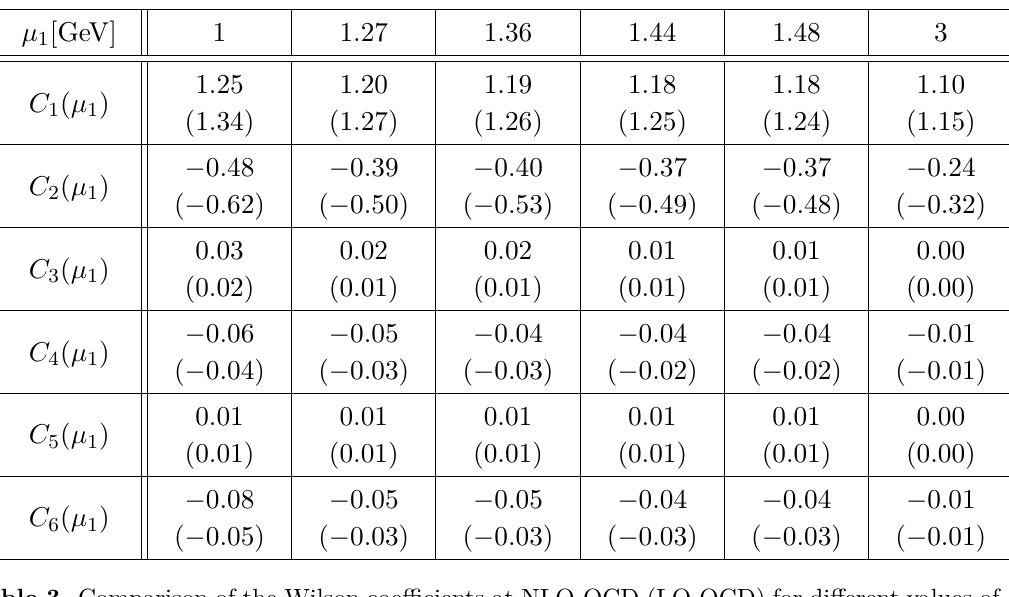
Table 3 . Comparison of the Wilson coefficients at NLO-QCD (LO-QCD) for different values of µ 1